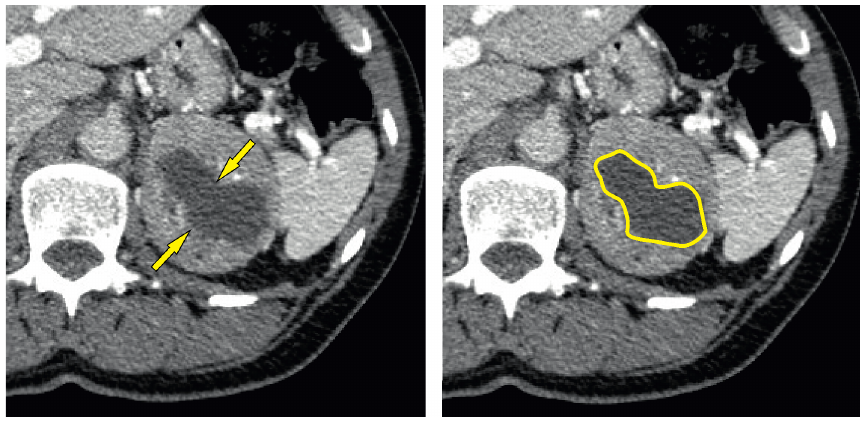
Fig. 1. Sharp necrosis. The arrows point to the borders of the sharp necrosis. The uninterrupted closed line defines the borders of the sharp